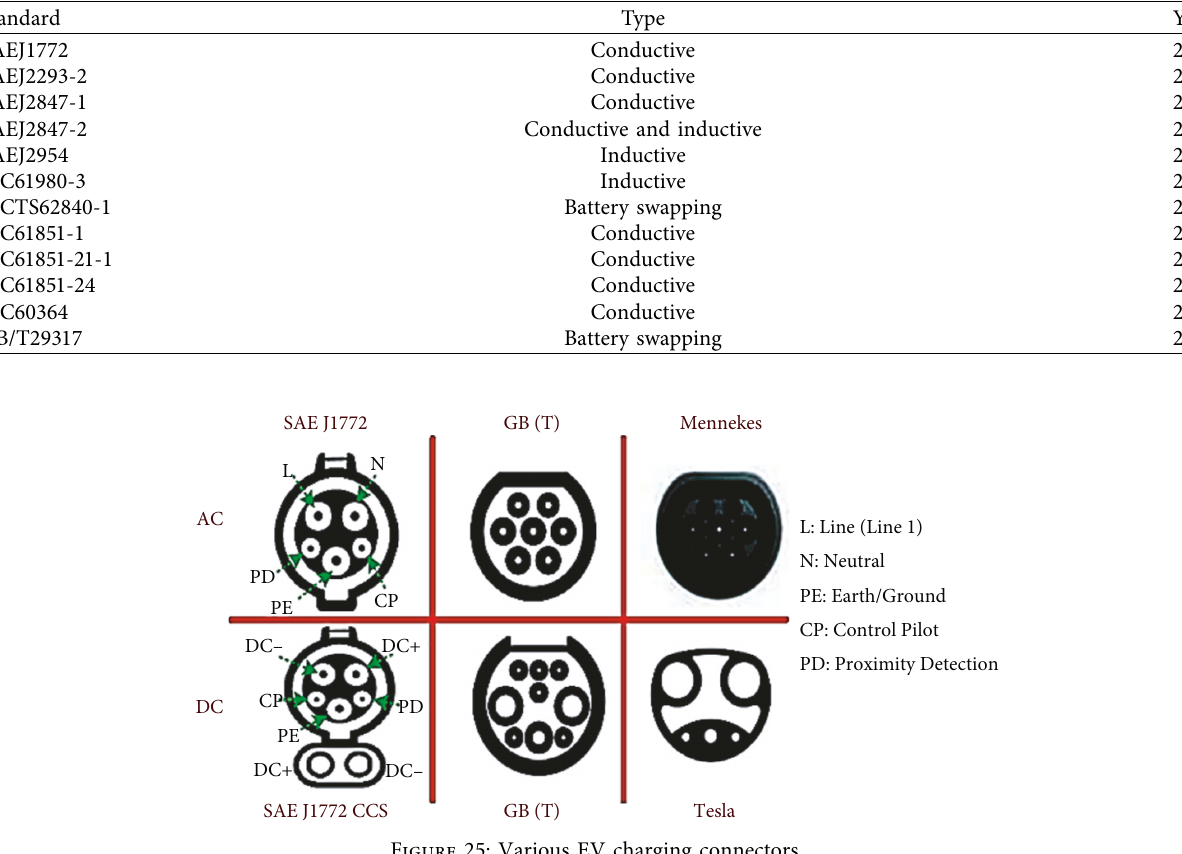
Table 6: Standards of EV charging.